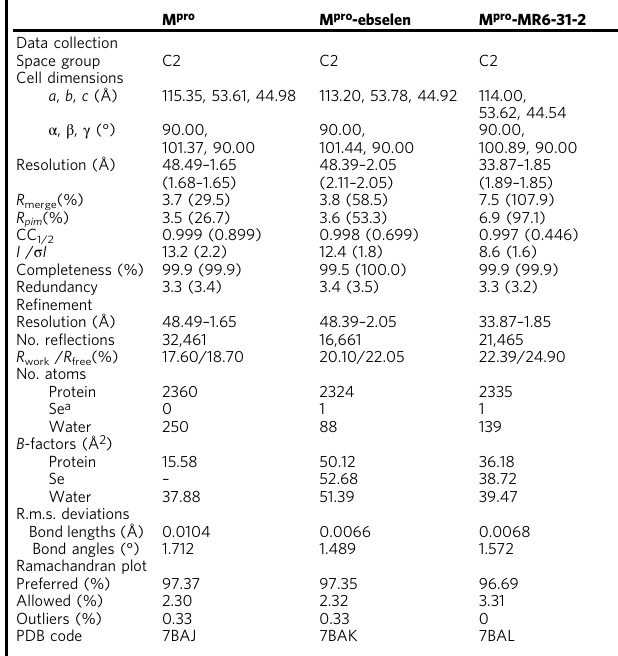
Table 1 Crystallographic data collection and re fi nement statistics of M pro and the complexes with ebselen and